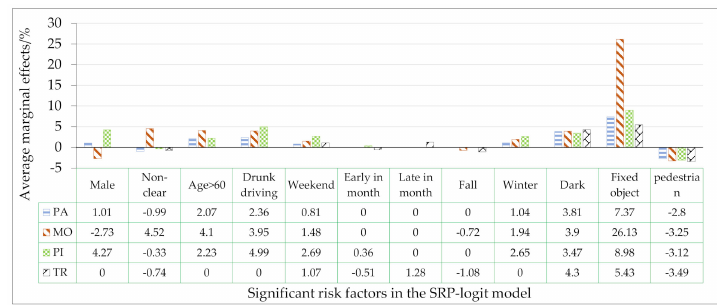
Figure 4. Average marginal effect of significant risk